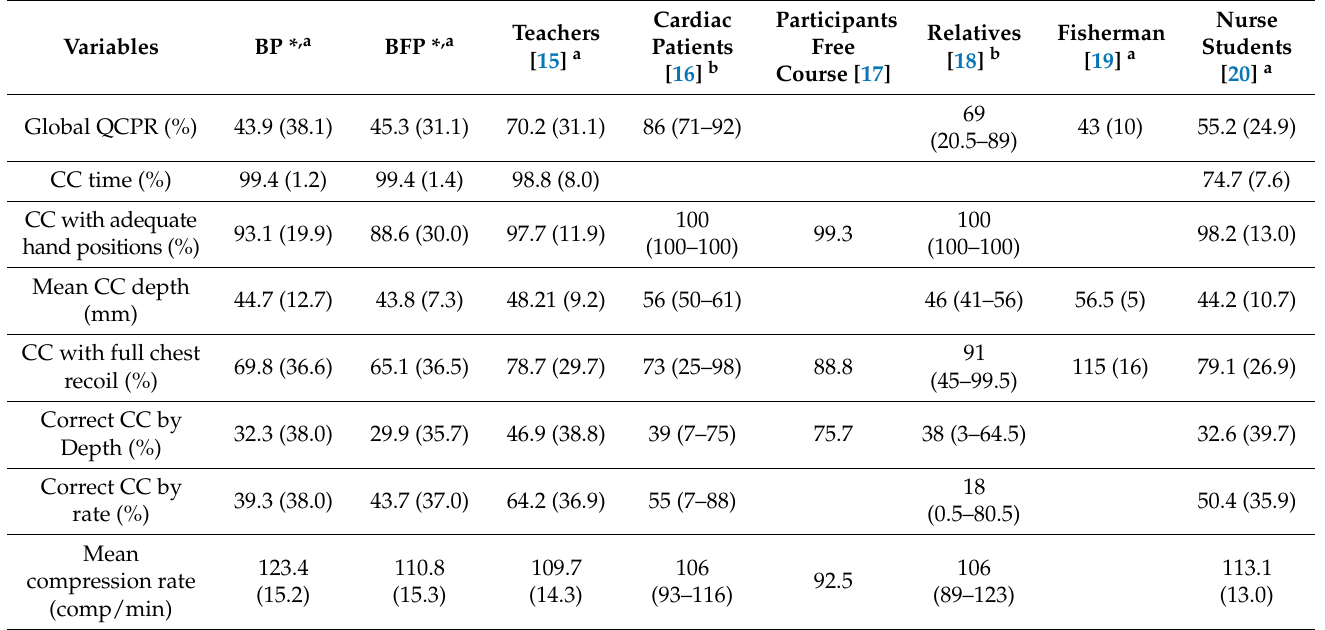
Table 2. Comparison of chest compressions quality standards obtained by BP, BFP and other laypersons after brief training. Variables BP * ,a BFP * ,a